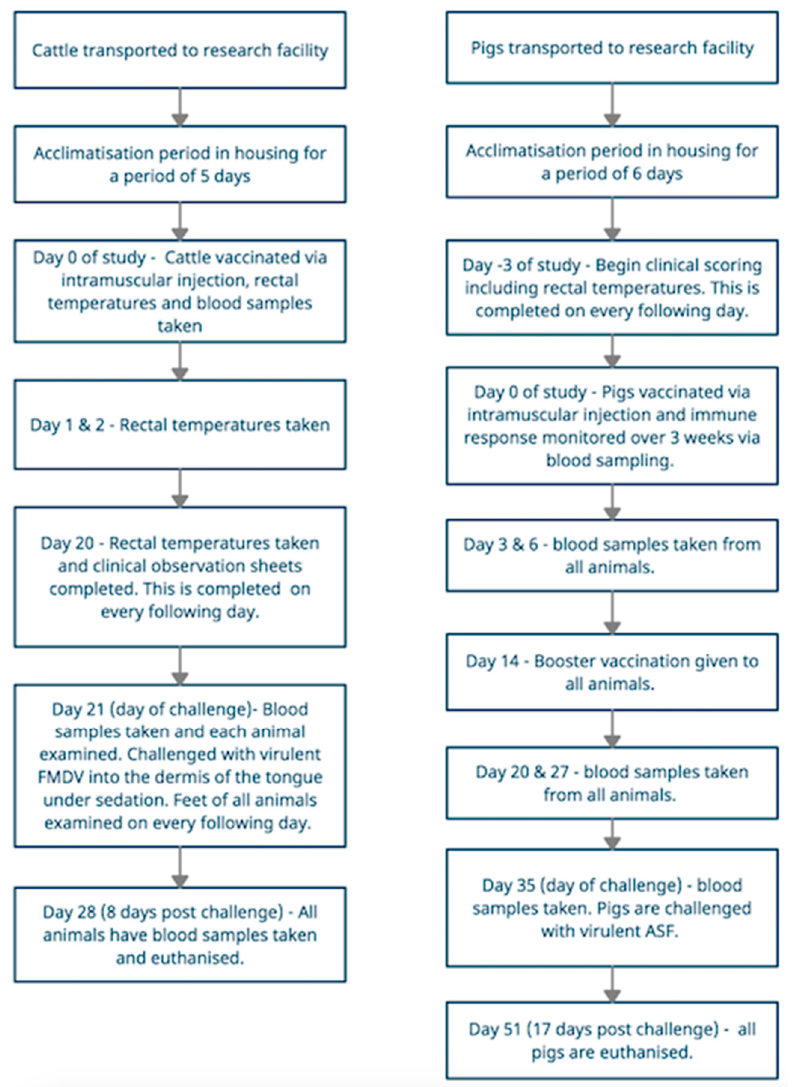
Figure 2. Flow charts showing the procedural events for cattle infected with Foot and Mouth Disease, and pigs infected with African Swine Fever. Animal welfare assessment grids were completed for every event taking place.